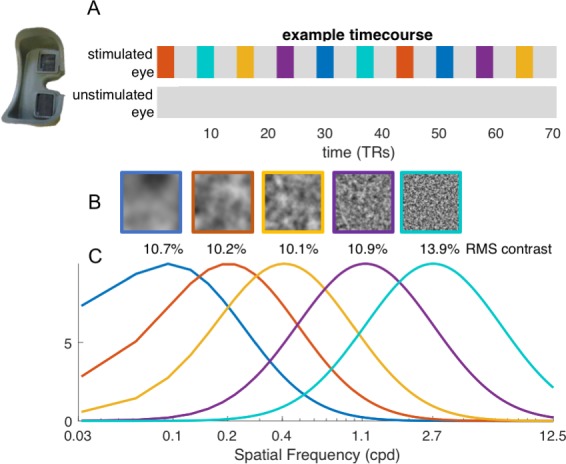
Bandpass noise stimuli.(A) example time-course of stimulation, showing the blocked presentation of the five spatial frequency stimuli. Blocks were presented in pseudo-random order, twice per run, for a total of 70 TRs. In each run, stimuli were only presented to one eye, while the other was shown a mid-level gray screen. Each eye was tested once, before and after deprivation. (B) example of the 2D bandpass noise stimuli, with their effective RMS contrast. (C) Normalized spectra of the bandpass filter that, multiplied by white noise, generated the five bandpass noise stimuli.